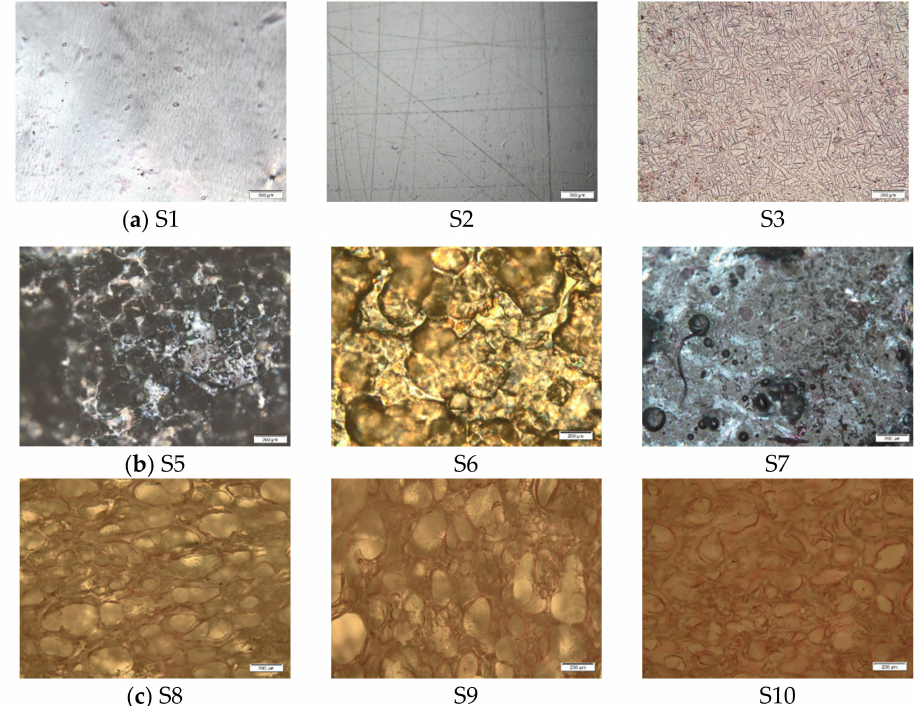
Figure 3. Photomicrographs of the printed samples obtained using polarized light microscopy (200 µ m): ( a ) subset I; ( b ) subset II and ( c ) subset